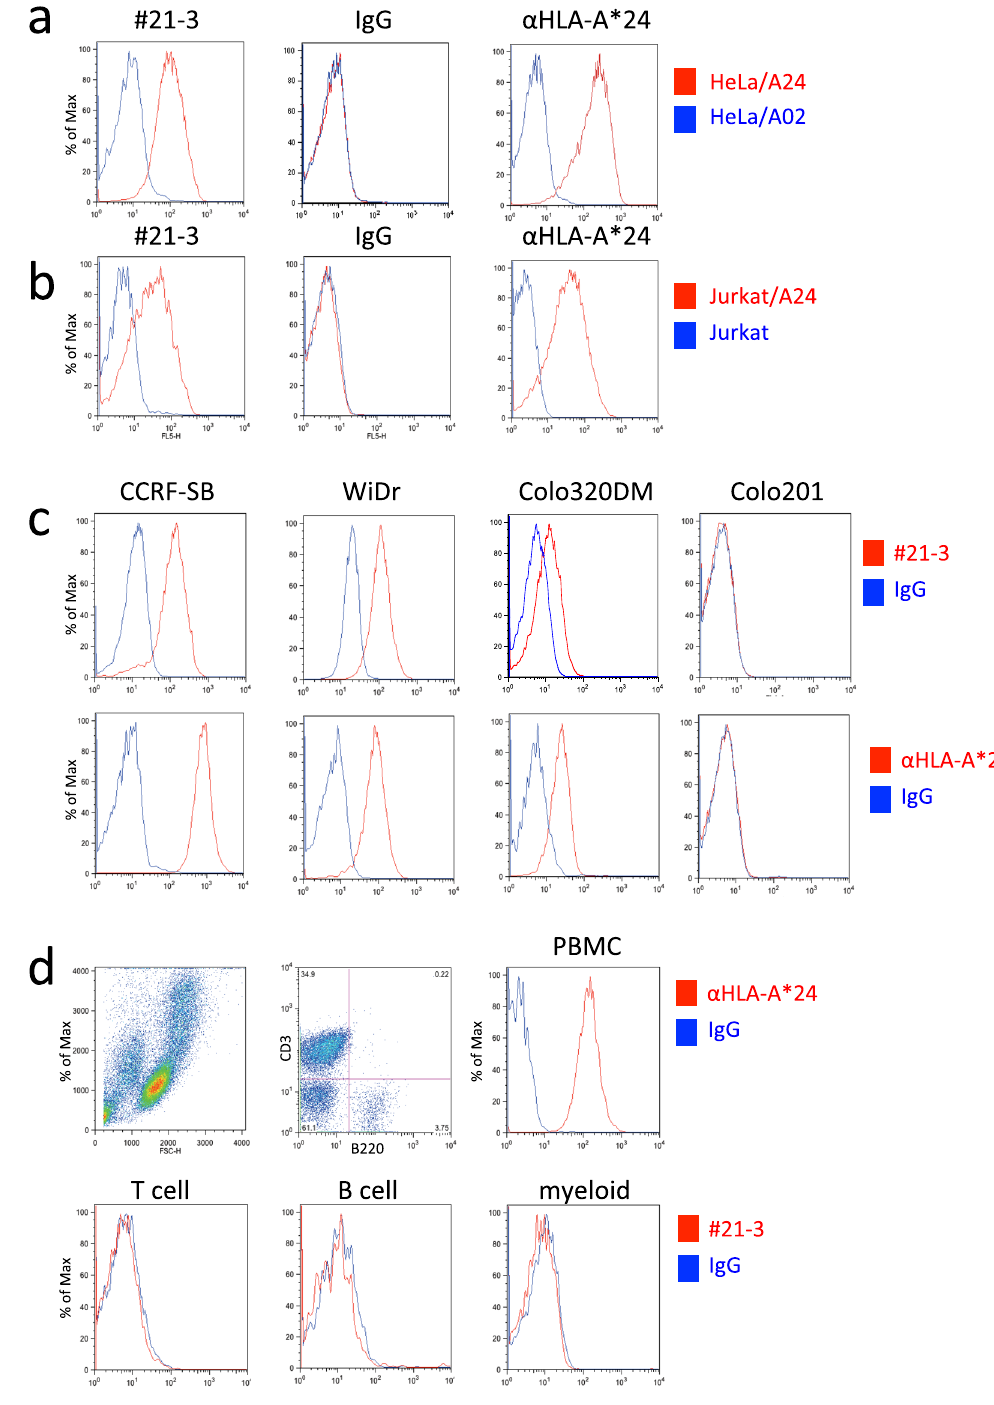
Figure 3. #21-3 detects endogenous SV2B 80-88 /HLA-A * 24 expressed on human tumor cell lines. ( a ) HeLa/ A02 or HeLa/A24 cells were labeled with #21-3 (0.1 µ g/mL) or control mouse IgG for 30 min at 4 °C and were analyzed by FACS. The integrity of the peptide/HLA-A * 24 expression was confirmed with an antibody against HLA-A * 24. Representative FACS histograms are shown. ( b ) Jurkat/A24 cells were stained with #21-3 or control mouse IgG and were analyzed as described above. ( c ) The indicated human tumor cell lines were stained with #21-3 or control mouse IgG, and binding was determined as described above. ( d ) PBMC from HLA-A * 24 + healthy donors were stained with #21-3. A representative gating strategy and #21-3 histogram compared with control mouse IgG are shown. All data are representative of two independent